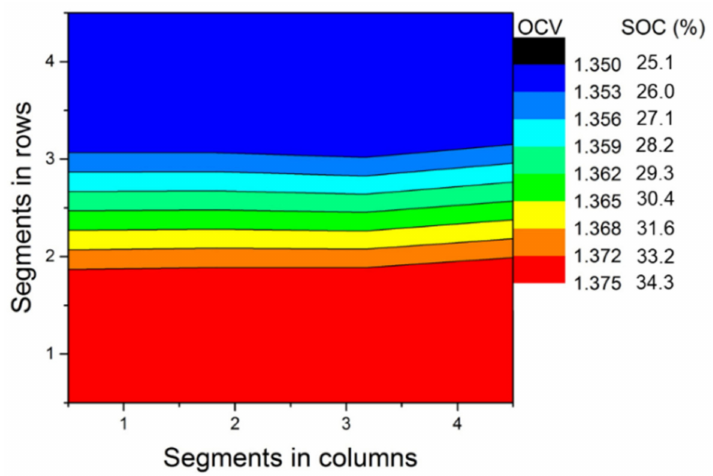
Figure 13. Contour diagram of OCV after terminating discharge (flow direction from bottom to